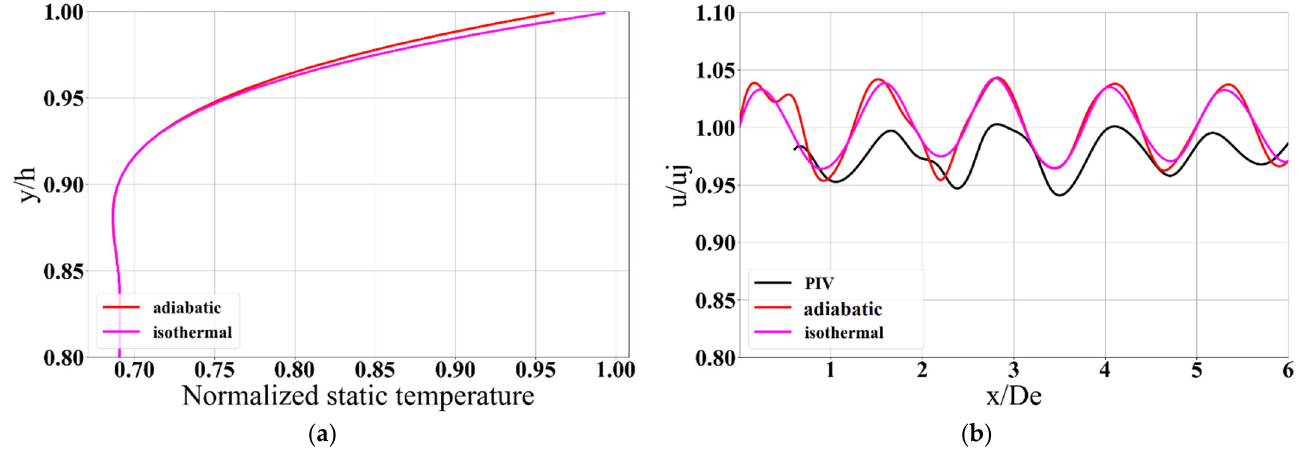
Figure 10. Effect of adiabatic and isothermal wall modeling on exit temperature profile and jet centerline velocity compared with PIV data from [60]. ( a ) Nozzle exit temperature profile. ( b ) Jet centerline velocity.